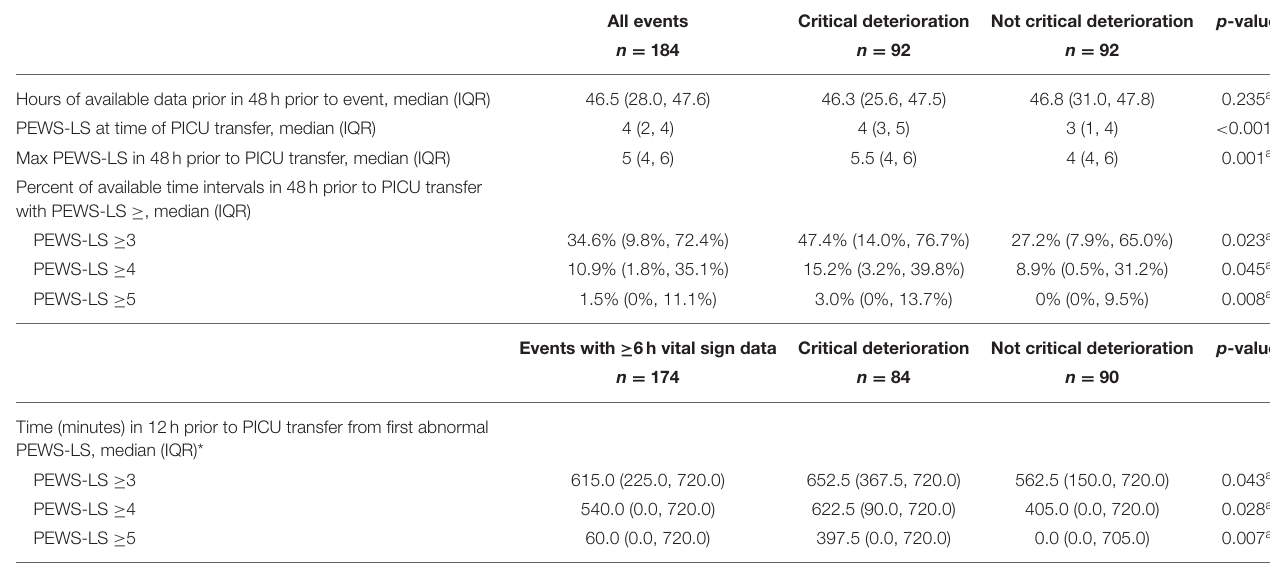
TABLE 3 | PEWS-like-score (PEWS-LS) and critical deterioration in hospitalized pediatric hematology-oncology patients. All events Critical deterioration Not critical deterioration p -value n = 184 n = 92 n = 92 Hours of available data prior in 48h prior to event, median